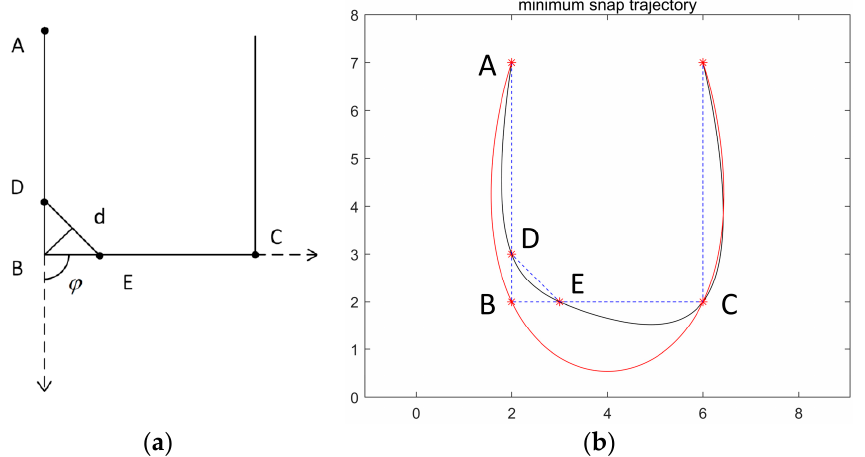
Figure 5. Principle and optimization effect of isosceles triangle function. ( a ) Schematic diagram of optimizing path length effect. ( b ) Schematic diagram of optimizing trajectory deviation effect.